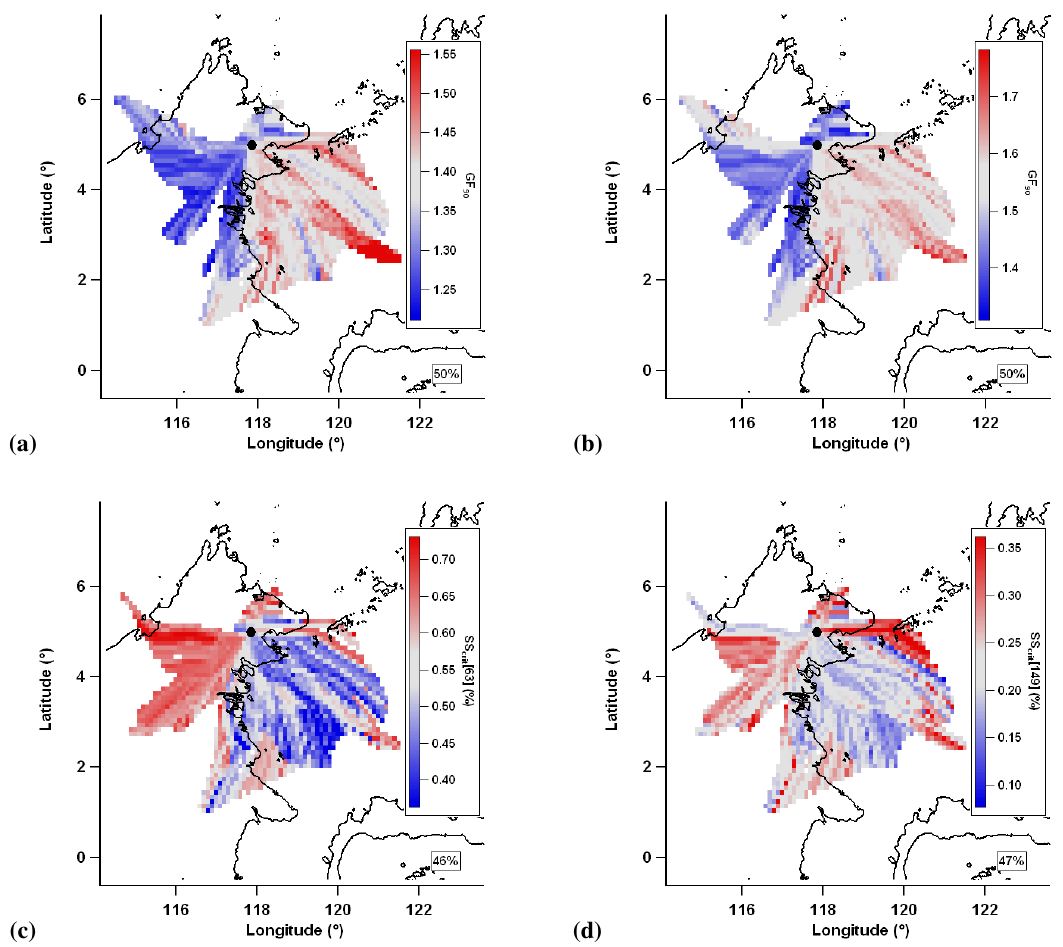
Fig. 20. Mean value maps of: sub-saturated growth factor for (a) 53nm particles and (b) 155nm particles; and critical supersaturation for (c) 63nm particles and (d) 149nm particles. Grey is median value, red is greater than median, blue is less than median and white denotes no data coverage. 36h trajectories are used.